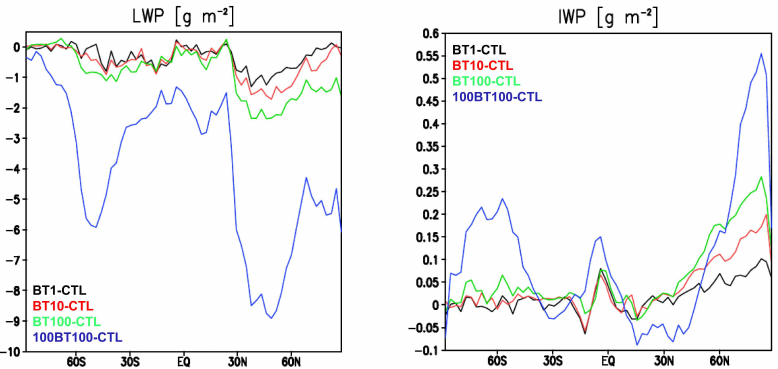
Fig. 7. Modelled annual zonal mean vertically integrated difference between the simulations with 1% of bacteria acting as IN (simulation BT1, black line), 10% of bacteria acting as IN (simulation BT10, red line), 100% of bacteria acting as IN (simulation BT100, green line), 100% of hundredfold bacteria acting as IN (simulation 100BT100, blue line) and no bacteria acting as IN (simulation CTL), for the ice water path (IWP) and liquid water path (LWP),